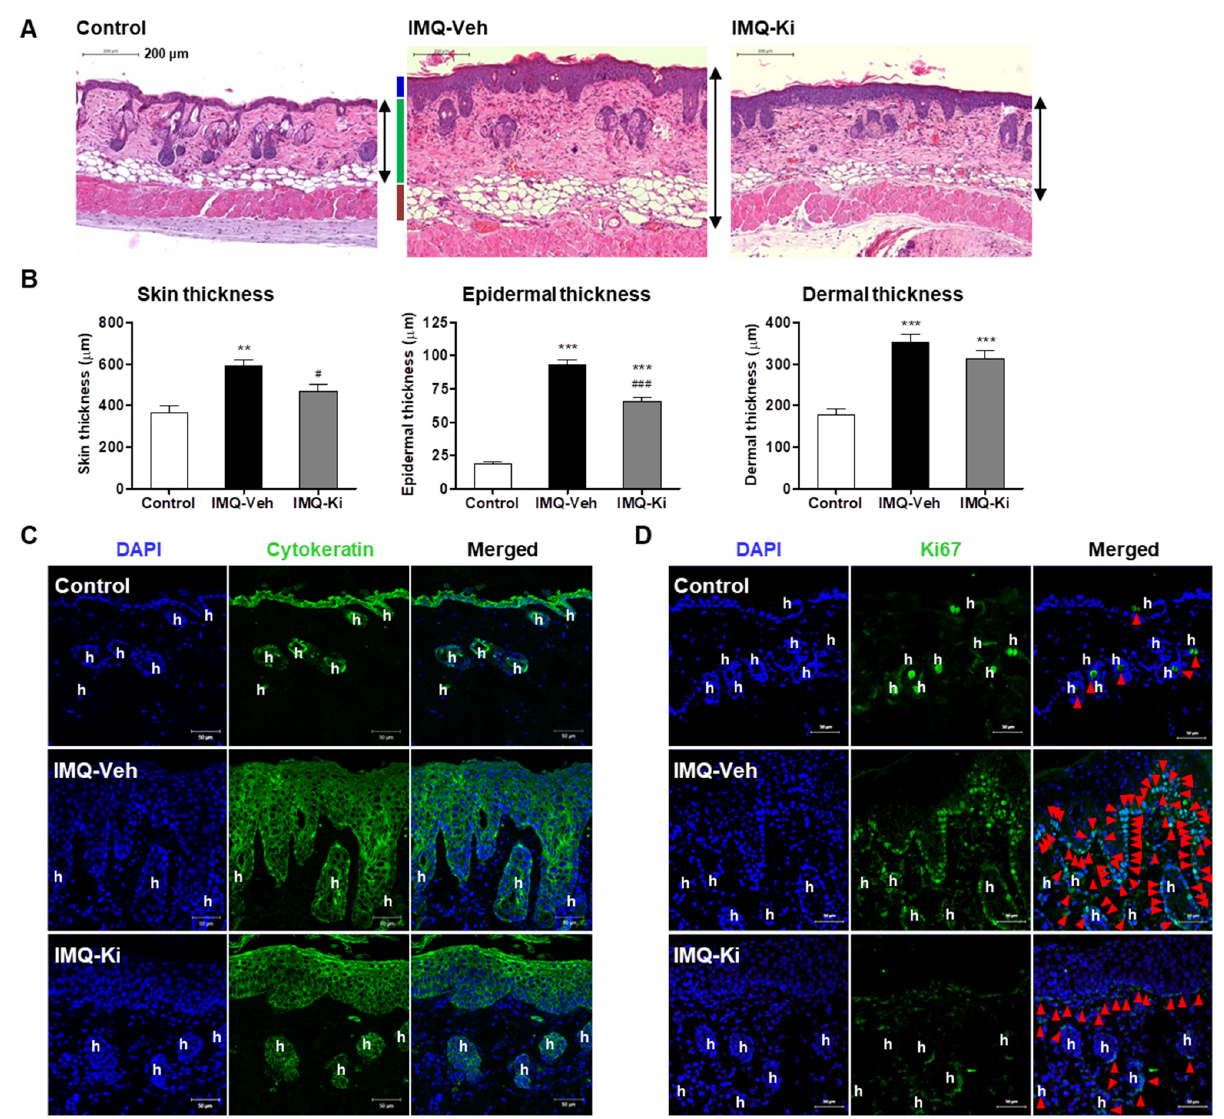
Figure 2. Ki16425 decreases epidermal thickening and keratinocyte proliferation in imiquimod (IMQ)-induced psoriasis-like mice. ( A ) The dorsal skin tissue sections were stained with hematoxylin and eosin (H&E). The representative photographs are shown (original magnification, 200 × ). ( B ) H&E-stained tissue sections were analyzed for the thickness in skin, epidermis, and dermis. The data are represented as the mean ± standard error of the mean (SEM). ** p < 0.01, *** p < 0.005 vs. Control; # p < 0.05, ### p < 0.005 vs. IMQ-Veh. ( C ) The dorsal skin tissue sections were stained for cytokeratin (green) antibody for epithelium and DAPI (blue) for nuclei staining. ( D ) The dorsal skin tissue sections were stained for Ki67 (green) antibody for proliferating cells and DAPI. Red arrowheads indicate green-positive cells. Scale bars: 50 µ m. h, hair follicle.